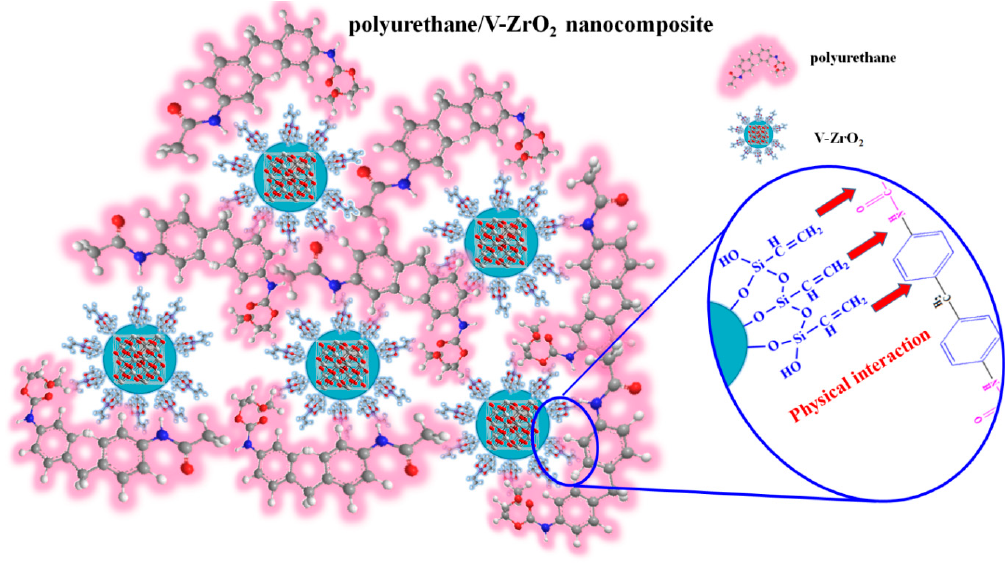
Figure 7. Typical interaction and dispersion state of V-ZrO 2 nanoparticles in PU matrix. Table 2. Decomposition parameters based on the n th order decomposition reaction of PU and PU nanocomposites calculated using di ff erent isoconversional kinetic